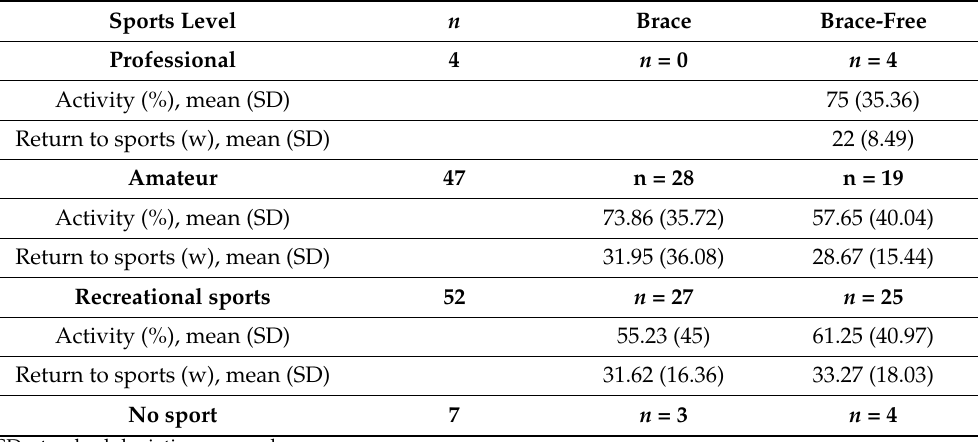
Table 3. Pre-existing injuries and previous interventions on the contralateral side. Pre-Existing Injuries and Previous